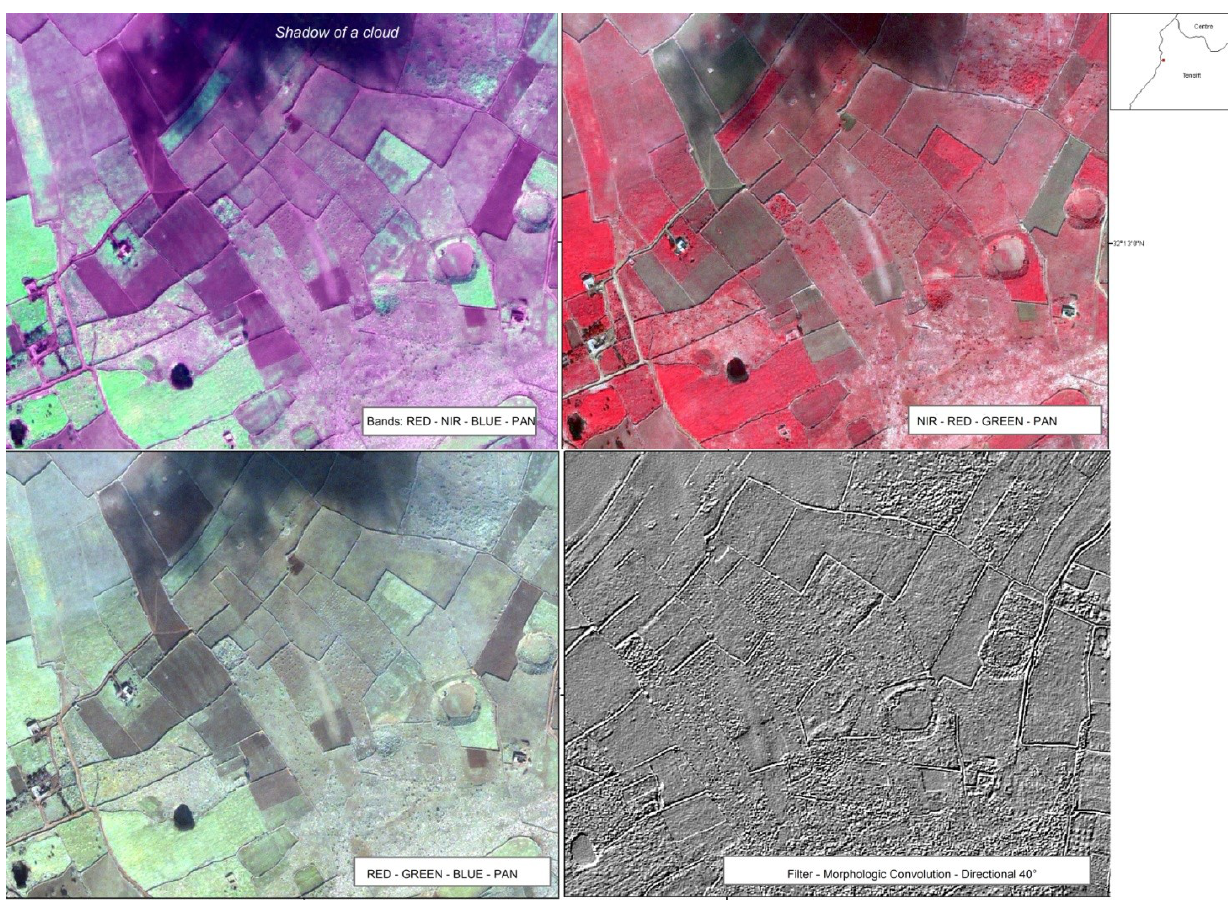
Figure 16. Dolines in the south of Safi visible on IKONOS_2 scenes (acquisition date: 14 January 2006) as flat, bowl-shaped depressions and circular, water-filled ponds in different band